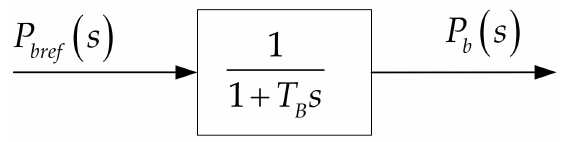
Figure 2. Mathematical model of BES.